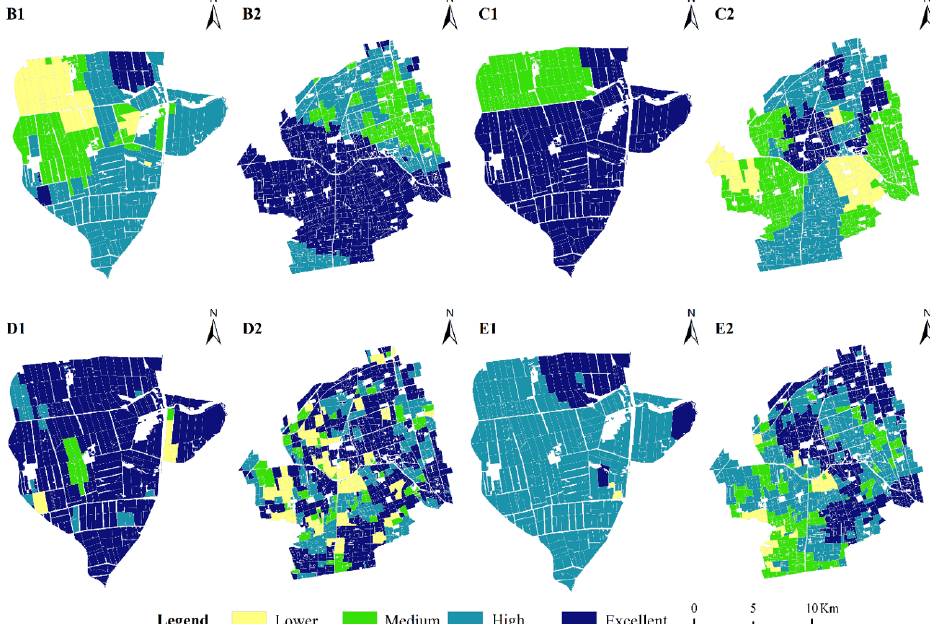
Figure 4. Relationship analysis of cultivated land individual qualities: B, C, D, and E represent the fertility quality, project quality, landscape quality, and ecology quality, respectively. Specifically, ( B1 ) is the spatial distribution of fertility quality in the modern agricultural area. ( B2 ) is spatial distribution of fertility quality in traditional agricultural area. ( C1 ) is the spatial distribution of project quality in the modern agricultural area. ( C2 ) is the spatial distribution of project quality in the traditional agricultural area. ( D1 ) is the spatial distribution of landscape quality in the modern agricultural area. ( D2 ) is the spatial distribution of landscape quality in the traditional agricultural area. ( E1 ) is the spatial distribution of ecology quality in the modern agricultural area. ( E2 ) is the spatial distribution of ecology quality in the traditional agricultural